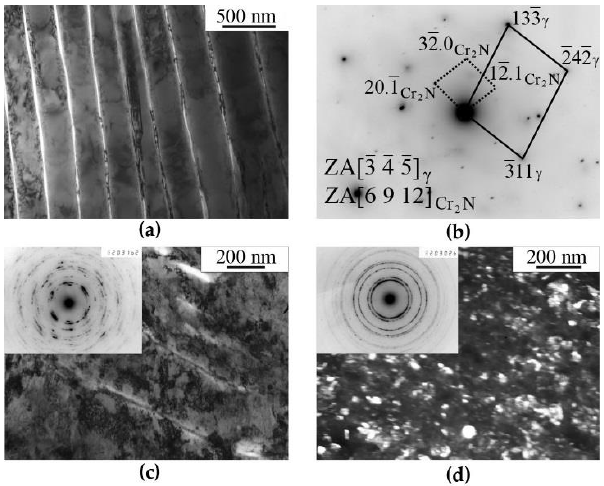
Figure 3. Structure of ( a ) aged and ( c , d ) deformed FeMn 22 Cr 18 N 0.83 steel. Treatment: ( a ) quenching + aging at 1073 K, 30 h; ( c ) aging + HPT of n = 3 rev. at 298 K; ( d ) aging + HPT of n = 3 rev. at 573 K. ( a , c ) — bright-field images; ( d ) — dark- field images in the combined reflection (111)γ + (200)γ + Cr 2 N. Electron-diffraction pattern ( b ) corresponding to the image ( a ).